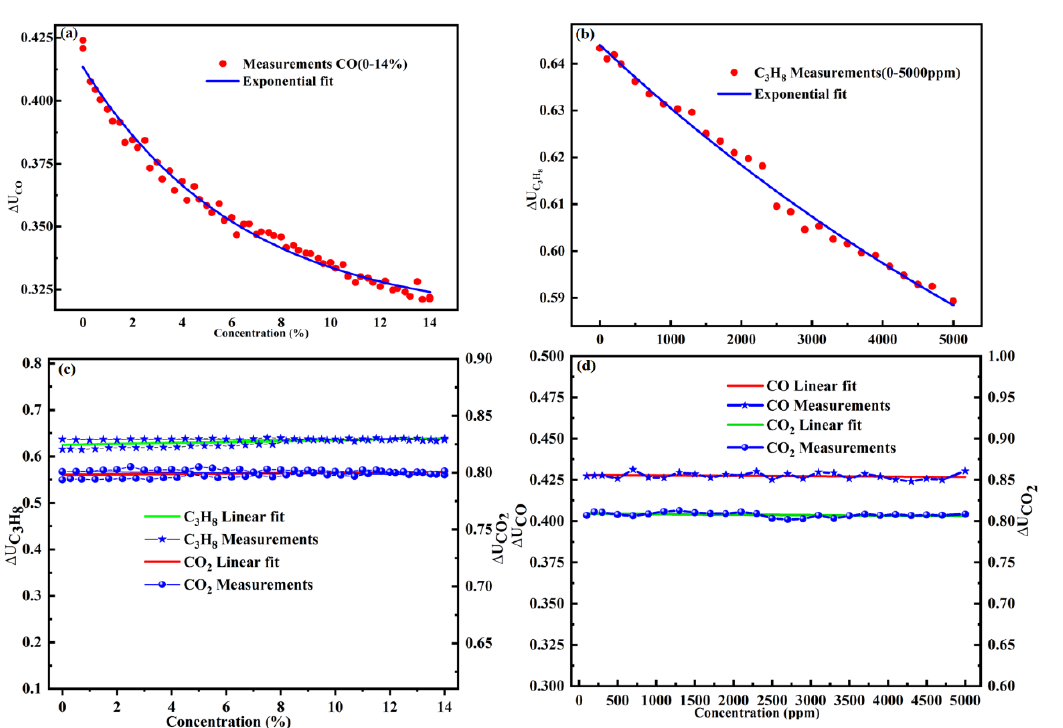
Figure 6. Measurements and fitting curve of the ratio △ U gas versus ( a ) CO; ( b ) C 3 H 8 ; ( c ) Cross interference of CO on CO 2 and C 3 H 8 ; ( d ) Cross interference of C 3 H 8 on CO 2 and C 3 H 8 .